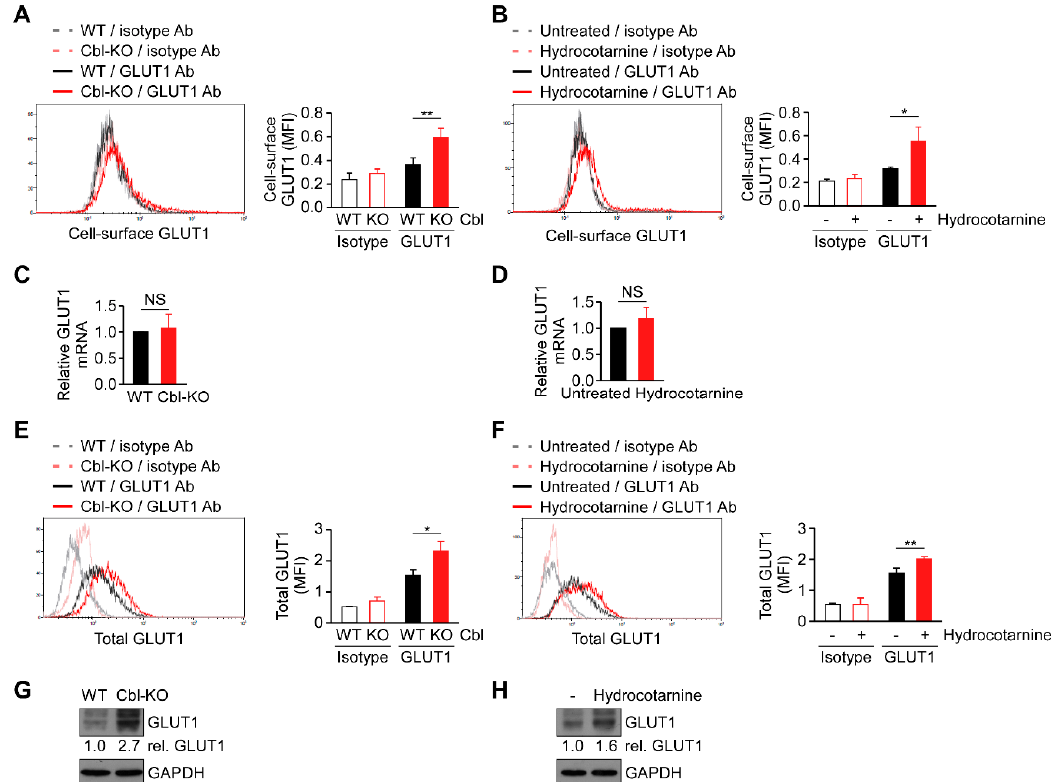
Figure 5. Cbl reduced glucose transporter 1 (GLUT1) protein expression through post-transcriptional regulation. Flow cytometry plots of three experiments on revealing the surface expression of GLUT1 protein in ( A ) WT and Cbl-KO THP-1-derived macrophages or in ( B ) hydrocotarnine-treated and untreated THP-1-derived macrophages. Changes in GLUT1 mRNA expression were assessed in ( C ) WT and Cbl-KO THP-1-derived macrophages or in ( D ) hydrocotarnine-treated and untreated THP-1-derived macrophages. Flow cytometry plots of three experiments on revealing the expression of total GLUT1 protein in ( E ) WT and Cbl-KO THP-1-derived macrophages or in ( F ) hydrocotarnine-treated and untreated THP-1-derived macrophages. Immunoblot analysis of GLUT1 in ( G ) WT and Cbl-KO THP-1-derived macrophages or in ( H ) hydrocotarnine-treated and untreated THP-1-derived